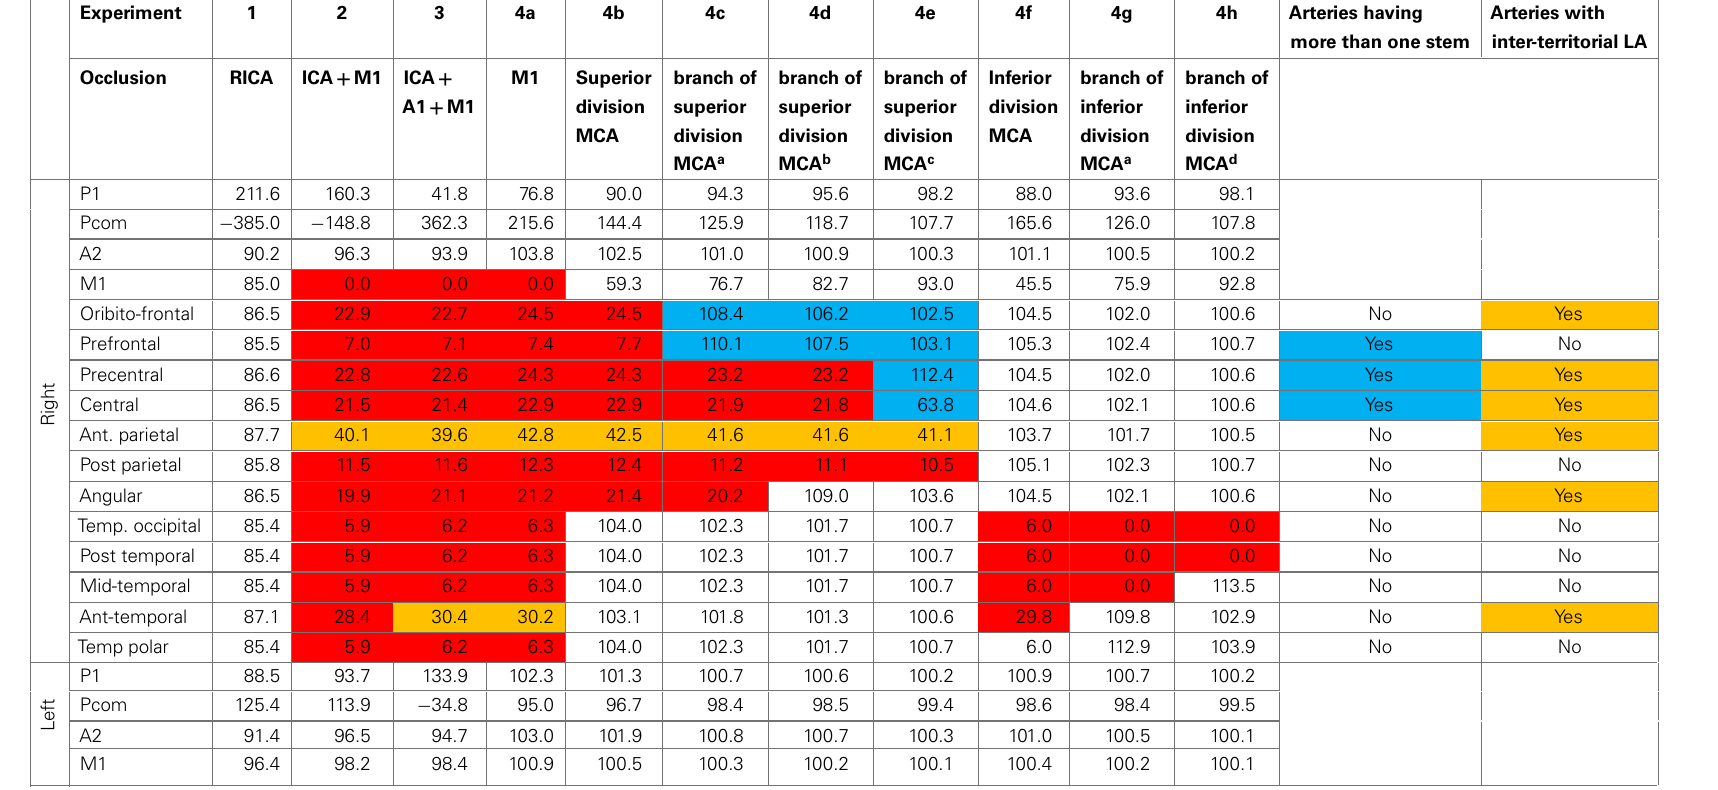
Table 3 | Effect of experimental arterial occlusion. Intra-territorial LA = 0.25mm, inter-territorial LA = 1.0mm .